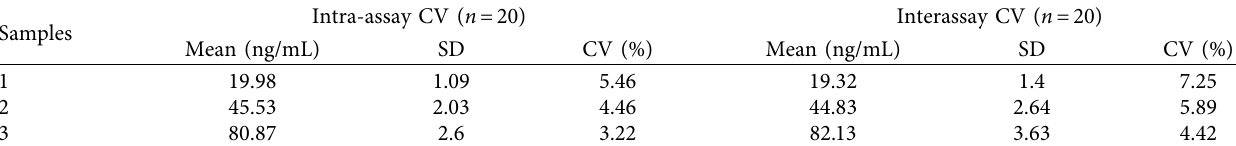
Table 3: Precision test results.